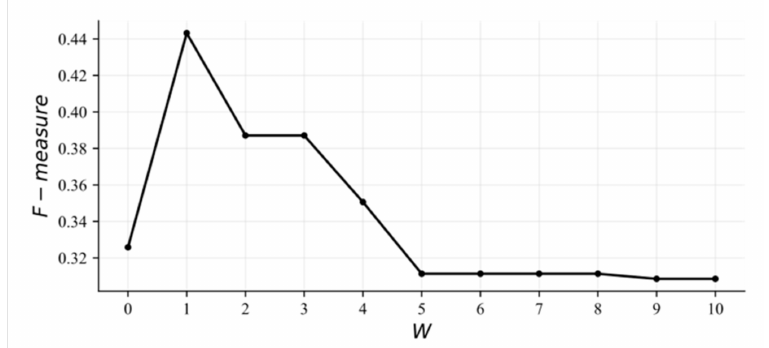
Figure 8. The F-measures for incentive factor w